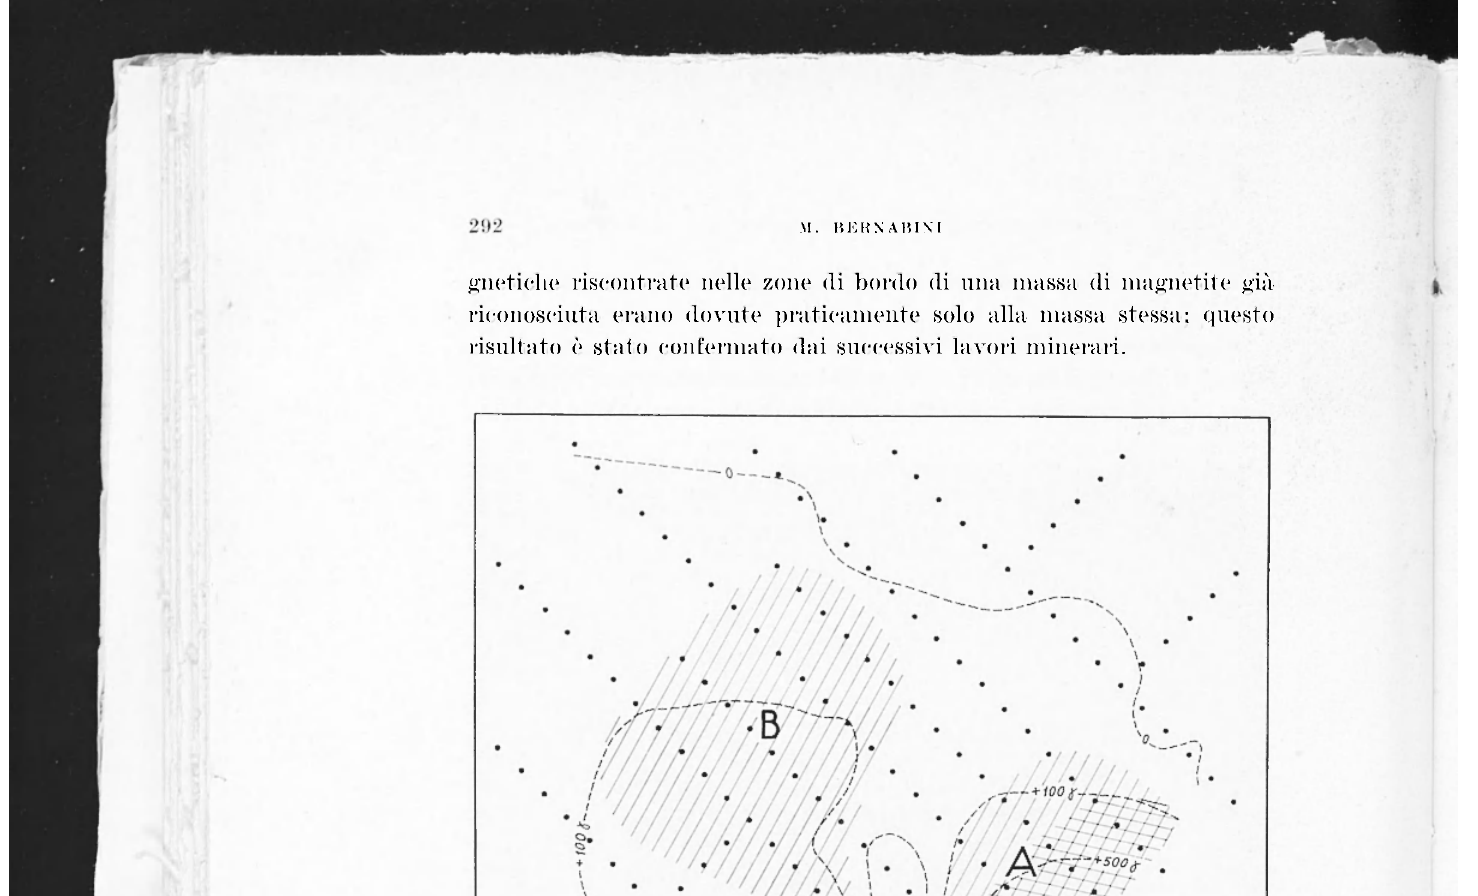
Fig. 8 - Ubicazione planimetrica delle masse di magnetite individuate con l'indagine